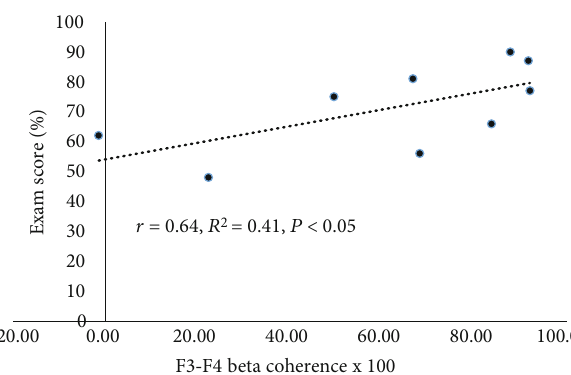
Figure 3: Association of midfrontal beta coherence and exam score. Linear regression analysis and line of best fi t demonstrating signi fi cant correlation between the beta coherence measured from the scalp overlying the midfrontal cortex and the second exam score. Subjects were 9 healthy male medical students studied 3d before each of their fi rst two block exams in an integrated anatomy-physiology course (Exam 1, Exam